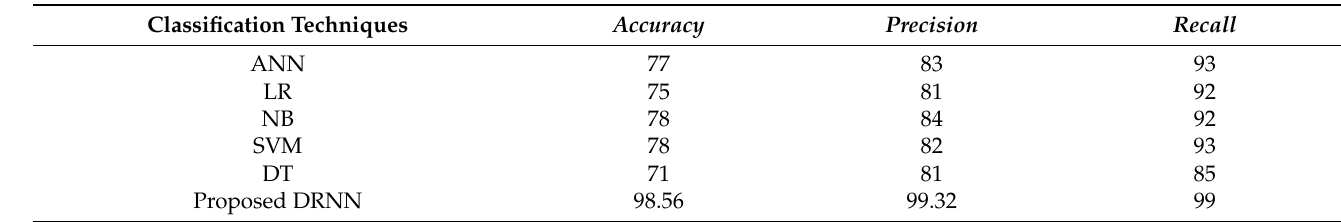
Table 1. Accuracy, precision, and recall measures of existing and proposed techniques. Classification